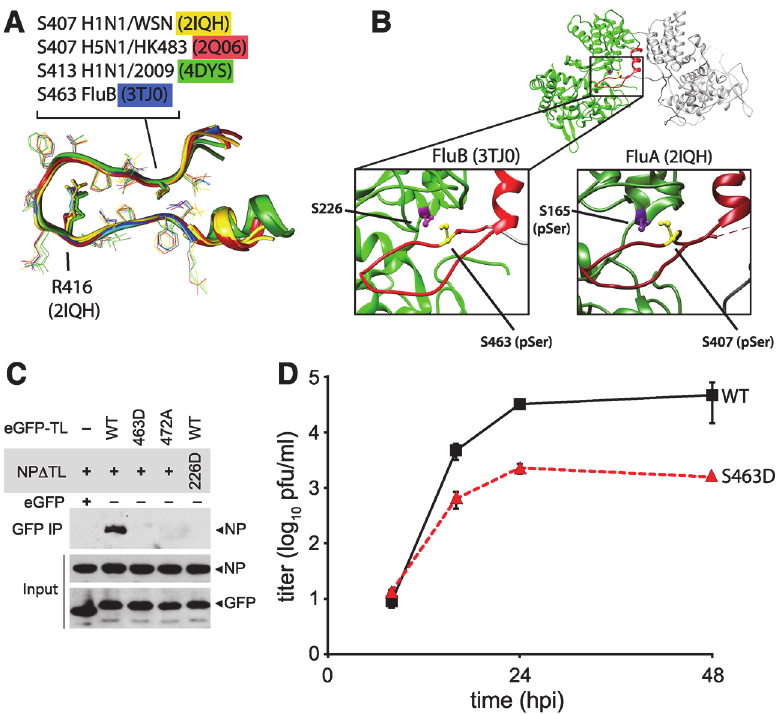
Fig 8. Phosphomimetic mutations in influenza B NP disrupt tail loop-binding groove interaction and attenuate virus replication. (A) Conserved tail loop conformations for influenza A and B virus NP. The phosphorylated NP S407 from influenza A NP is analogous to S463 in influenza B NP. NP derived from pandemic 2009 H1N1 (4DYS) contains a naturally occurring N-terminal addition, shifting the numbering scheme by six amino acids. (B) Interaction between individual protomers of influenza virus B NP. The tail loop is shown in red. For clarity, a cross-section of the structure is shown to reveal the tail-loop and binding groove. The spatial organization of S223 and S463 in influenza B NP is highlighted (left), revealing a nearly identical positioning to that of influenza A NP (right). (C) Tail loop:binding groove assay for influenza B NP using tail loop (R472A and S463D) and binding groove (S226D) mutants. Proteins were expressed in 293T cells and lysates were immunoprecipitated with anti-GFP antibody. Co-precipitating NP (upper panel) and proteins in the lysate (lower two panels) were analyzed by blotting with anti-V5 or anti-GFP antibodies. (D) Multicycle replication kinetics were examined in MDCK cells infected at an MOI of 0.01 with recombinant influenza B viruses encoding either WT or S463D mutant NP. Viral titers at the indicated time points were determined by plaque assay (n = 3 independent infections +/-